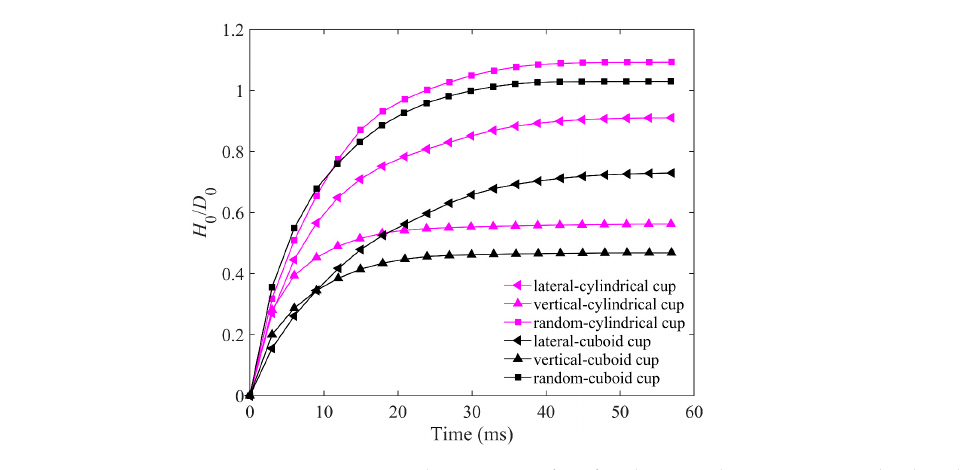
cup. The length of particles in the cup is AR = 5.